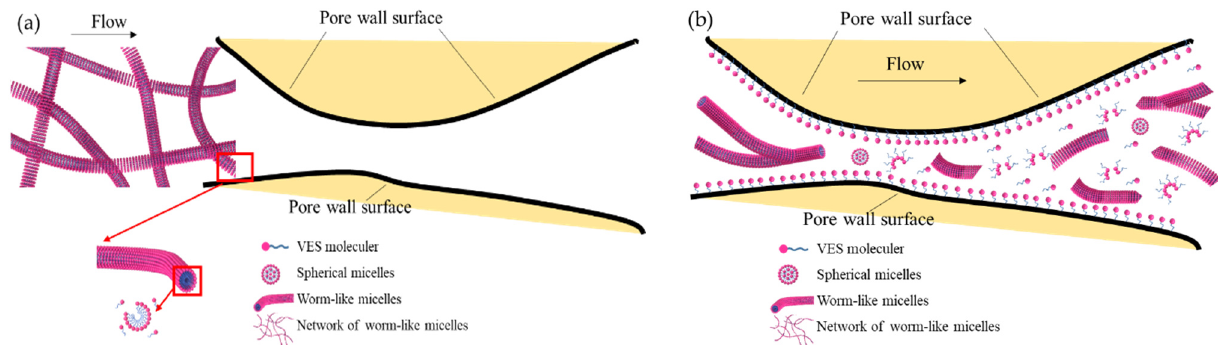
Figure 8. Wettability alteration through the pore throat in porous media: ( a ) before VES injection; ( b ) after VES flow.